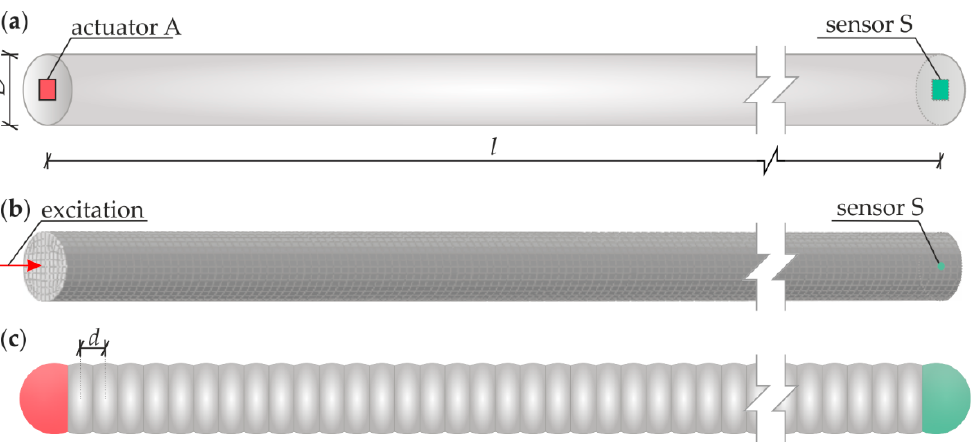
Figure 4. An object of research: ( a ) specimen geometry, ( b ) numerical FEM model, ( c ) numerical DEM model.